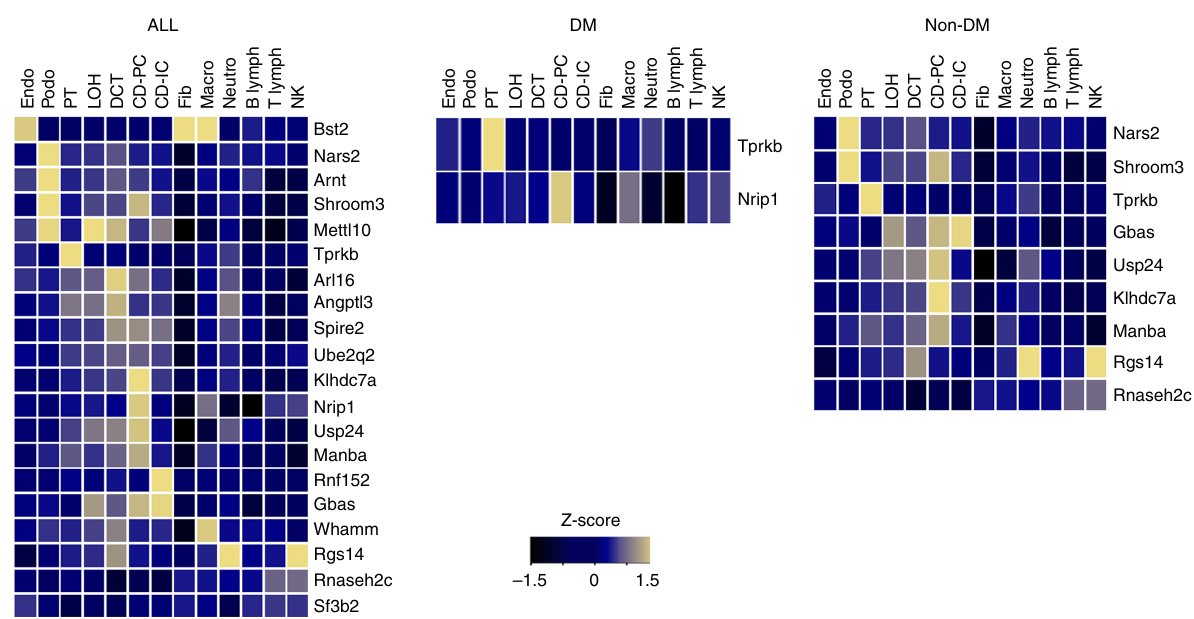
Fig. 3 Mapping eGFR-associated genes to kidney cell type clusters. Average expression level of GWAS/eQTL de fi ned genes across overall transethnic (ALL), diabetic (DM), and non-diabetic (Non DM) analyses. Mean expression values of the genes were calculated in each cluster. Color scheme is based on z -score distribution. Each row represents one gene and each column is single cell type cluster (as de fi ned by Park et al. 22 ) on the heatmap. Endo: endothelial, vascular, descending loop of Henle, Podo: podocyte, PT: proximal tubule, LOH: ascending loop of Henle, DCT: distal convoluted tubule, CD-PC: collecting duct principal cell, CD-IC: CD intercalated cell, Fib: fi broblast, Macro: macrophage, Neutro: neutrophil, NK: natural killer